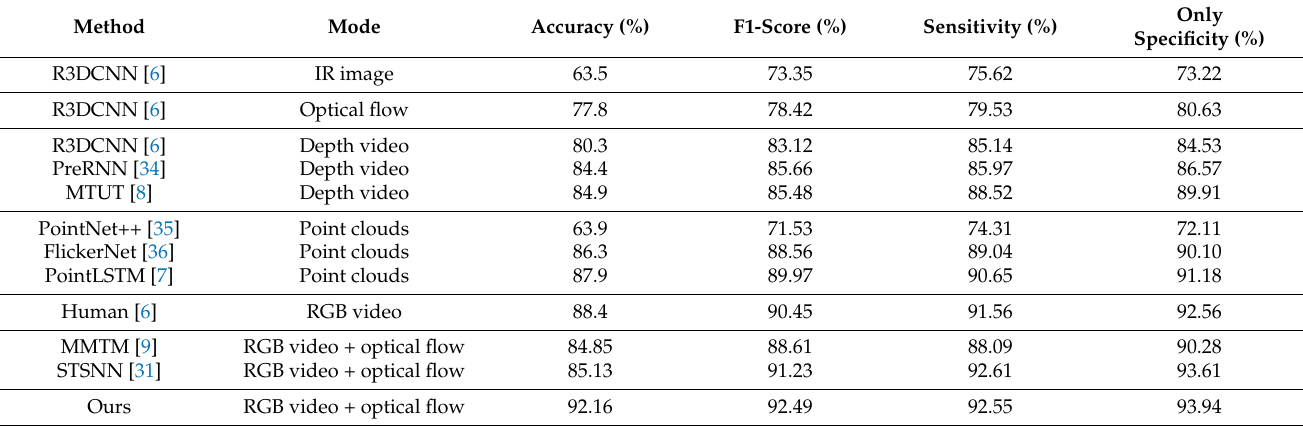
Table 3. Comparison of the proposed method on the NVGesture dataset.